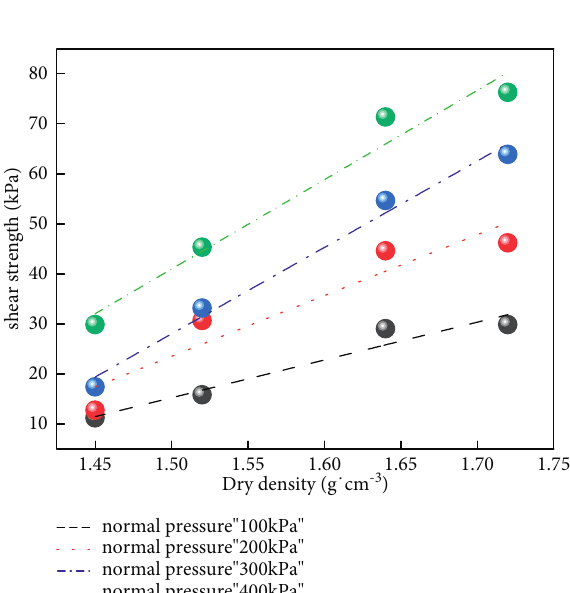
Figure 3: Relationship between dry density and shear strength of silty clay. Table 4: Curve fitting parameters of the relationship between dry density and shear strength under different normal pressure. Normal pressure